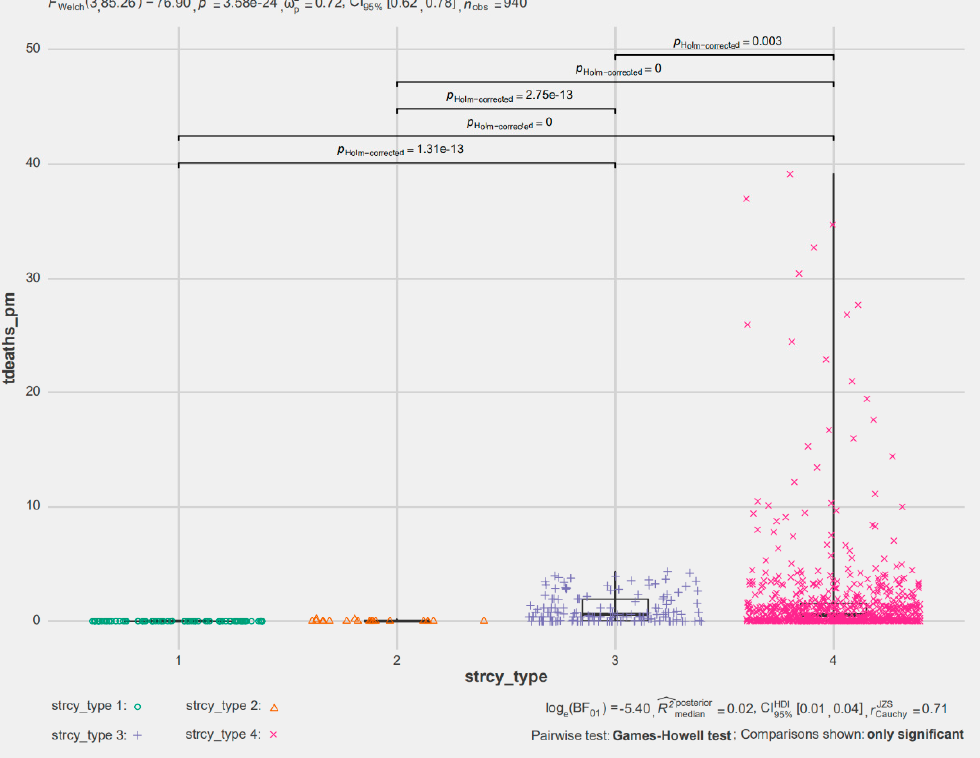
Table 4. Continuity test for control variables in regression discontinuity.